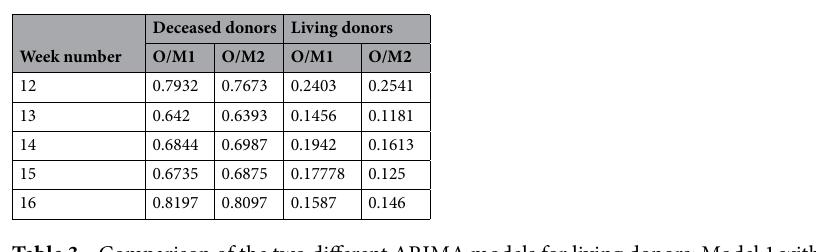
Table 3. Comparison of the two different ARIMA models for living donors: Model 1 with seasonality and Model 2 with seasonally adjusted data constructed by removing the seasonal component.